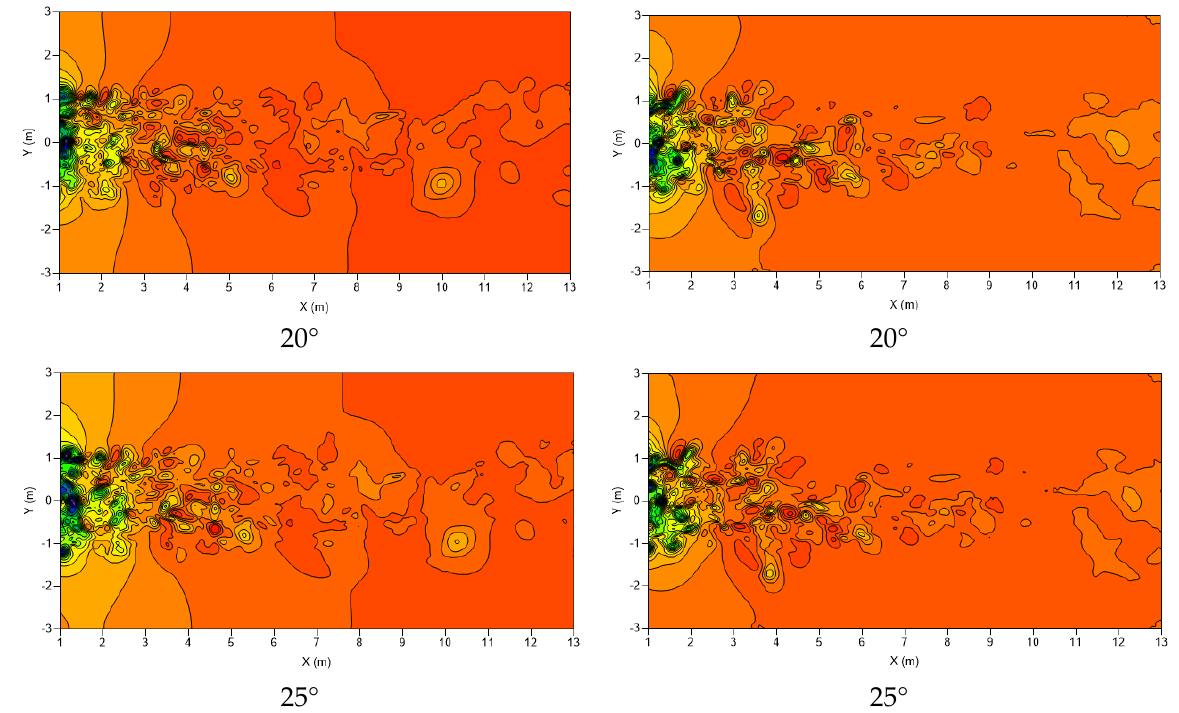
Figure 8. Spatial distribution of static gauge pressure (in Pa) in the wake region of healthy and damaged VAWTs.